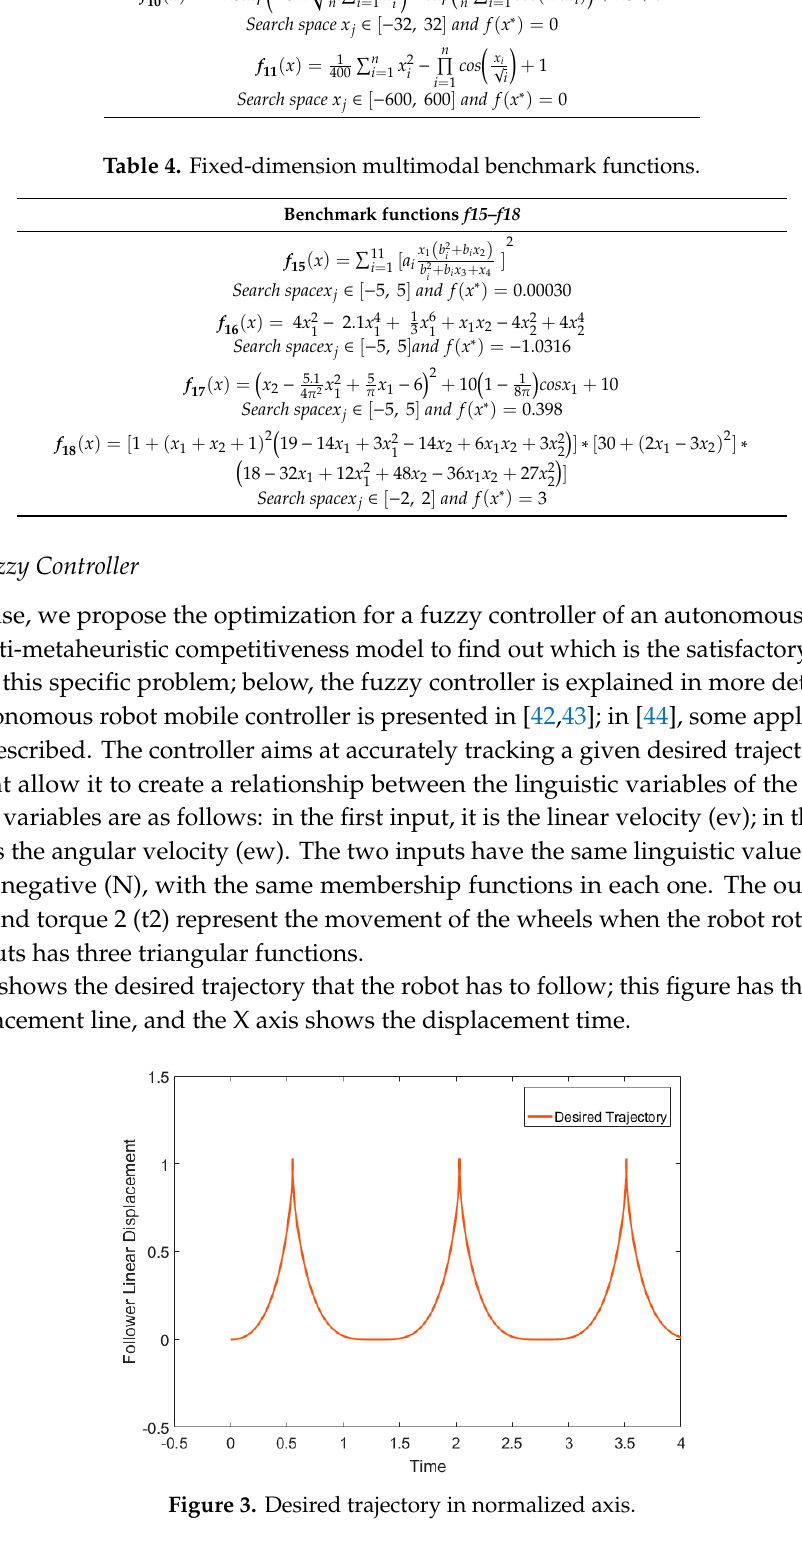
Figure 4. Obtained mean square error (MSE). Figure 4 shows the red line as the desired trajectory, and the actual trajectory of the robot in blue, and as can be seen, the robot is very much lost, since it generates a large error of 𝟑.𝟖𝟓𝟒𝟏 × 𝟏𝟎 (cid:2878)𝟎𝟑 .